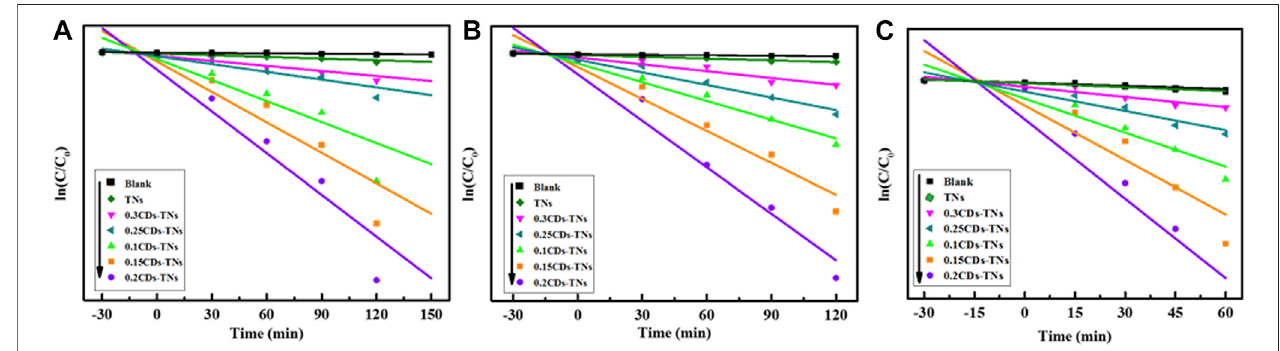
FIGURE 10 | The degradation kinetics curves of (A) CR, (B) RhB, and (C) TC by CD-TN composites with different contents of CDs under visible light.